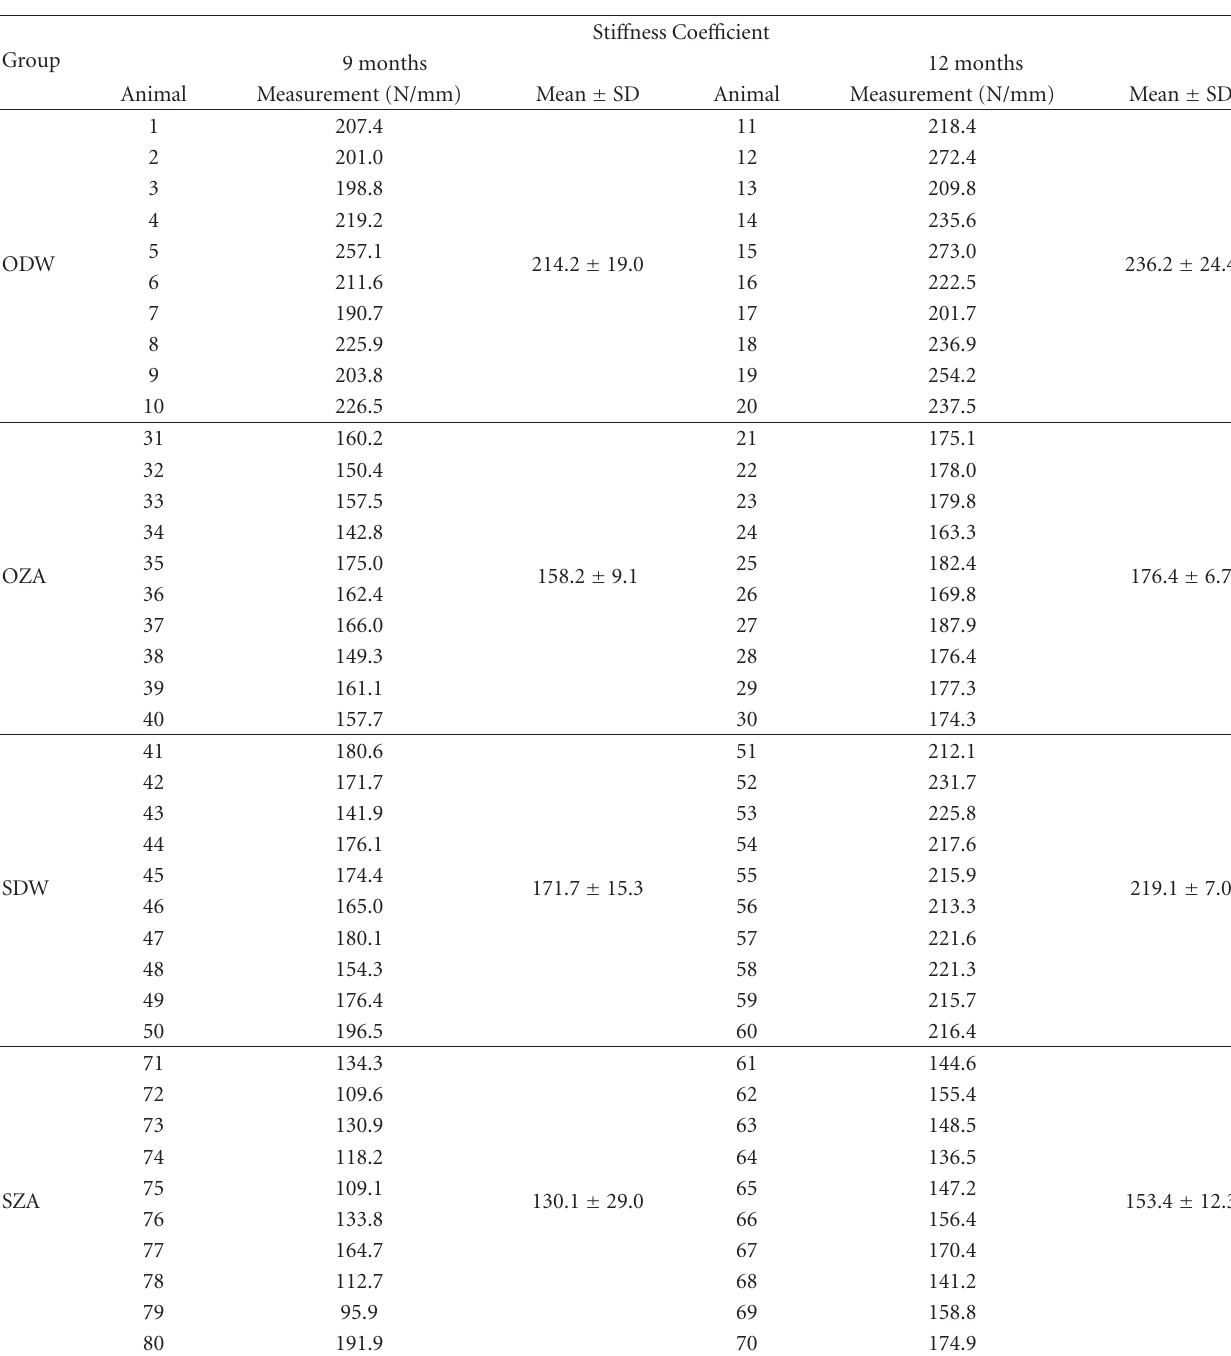
Table 3: Sti ff ness coe ffi cient (N/mm) at 9 and 12